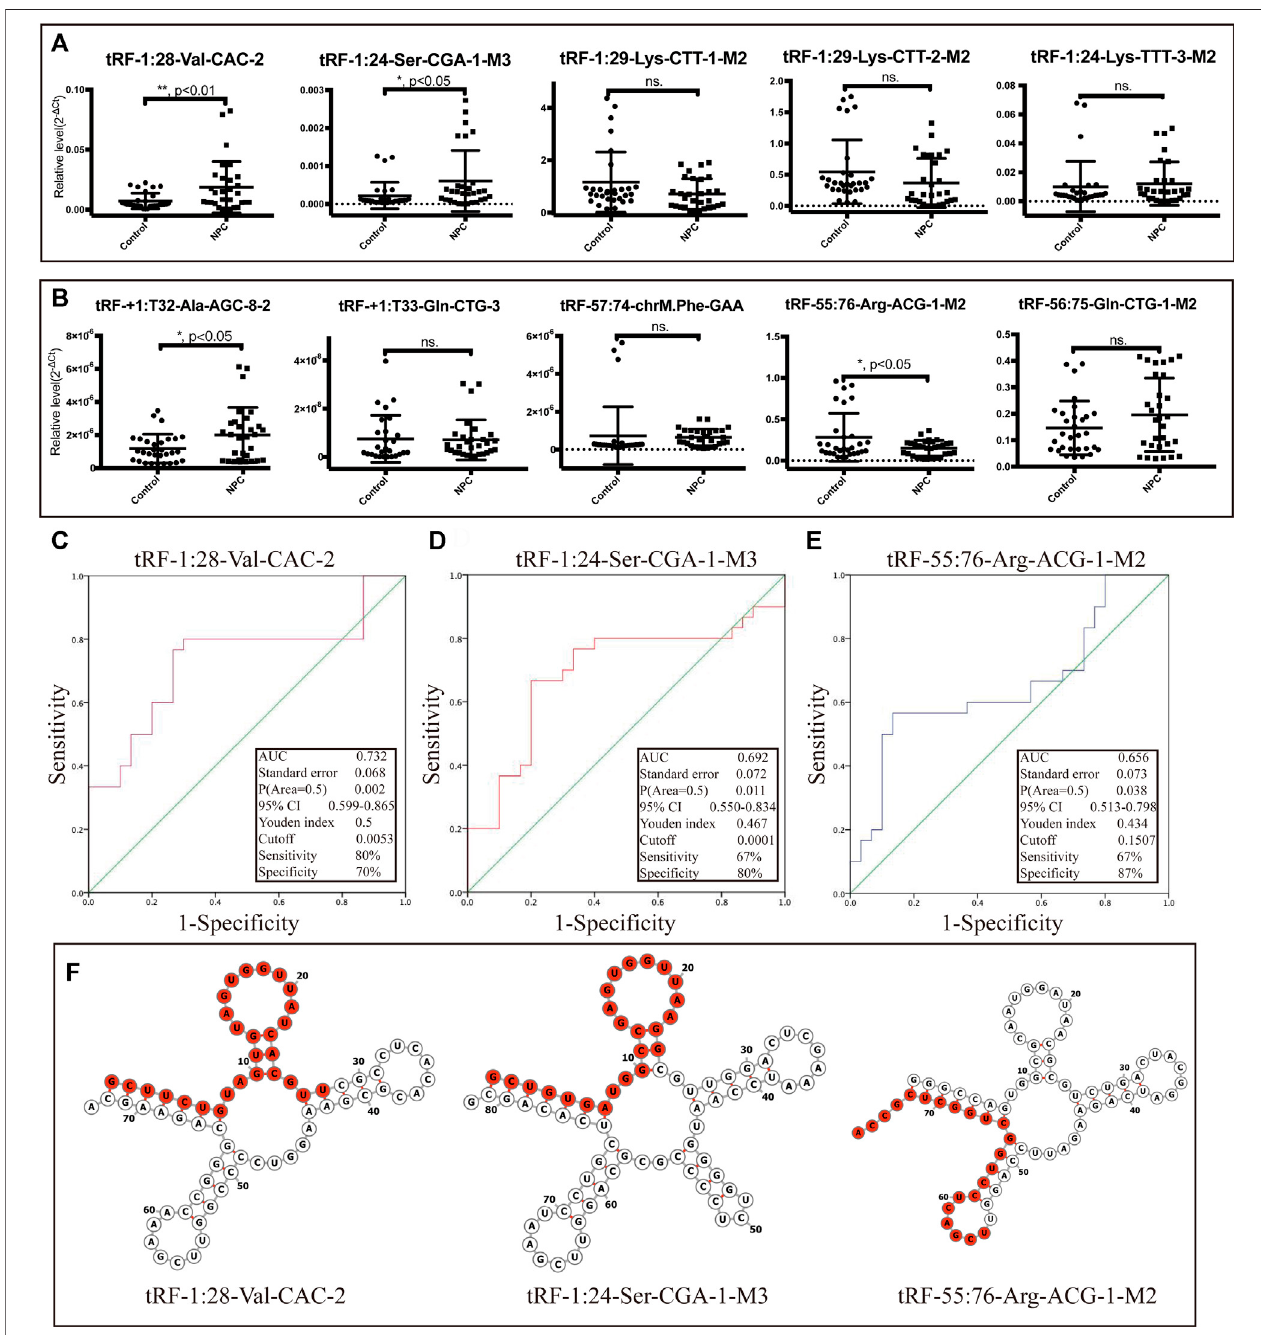
FIGURE 4 | Dysregulation of selected tsRNAs in NPC by qRT-PCR. We selected 10 tsRNAs dysregulated in NPC for custom qRT-PCR. (A) Expression of 5 tsRNAsupregulated inNPC. (B) Expression of5tsRNAs downregulatedin NPC aswell. All datawere analyzed using Student ’ s t -test(* p < 0.05, ** p < 0.01). ROCcurve analysis of (C) tRF-1:28-Val-CAC-2, (D) tRF-1:24-Ser-CGA-1-M3, and (E) tRF-55:76-Arg-ACG-1-M2. (F) Examples of tRNA or pre-tRNA structures of the three validated tsRNAs were depicted. The red nucleotides indicate the presence of the three validated tsRNA sequences.